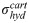
Obtained average hydrostatic stress and patella shape.Left: Average hydrostatic stress for the three analyzed cases- 1) 5%, 10%, 15%, 25% and 45% (weighting high flexion), 2) 60%, 25%, 9%, 5%, and 1% (weighting low flexion angles); 3) 1%, 5%, 9%, 25% and 60% (heavily weighting high flexion) for the 30°, 45°, 60°, and 90° respectively. Right: Patella shape: where the elements that have the hydrostatic stress above the tissue differentiation threshold σhydcart.